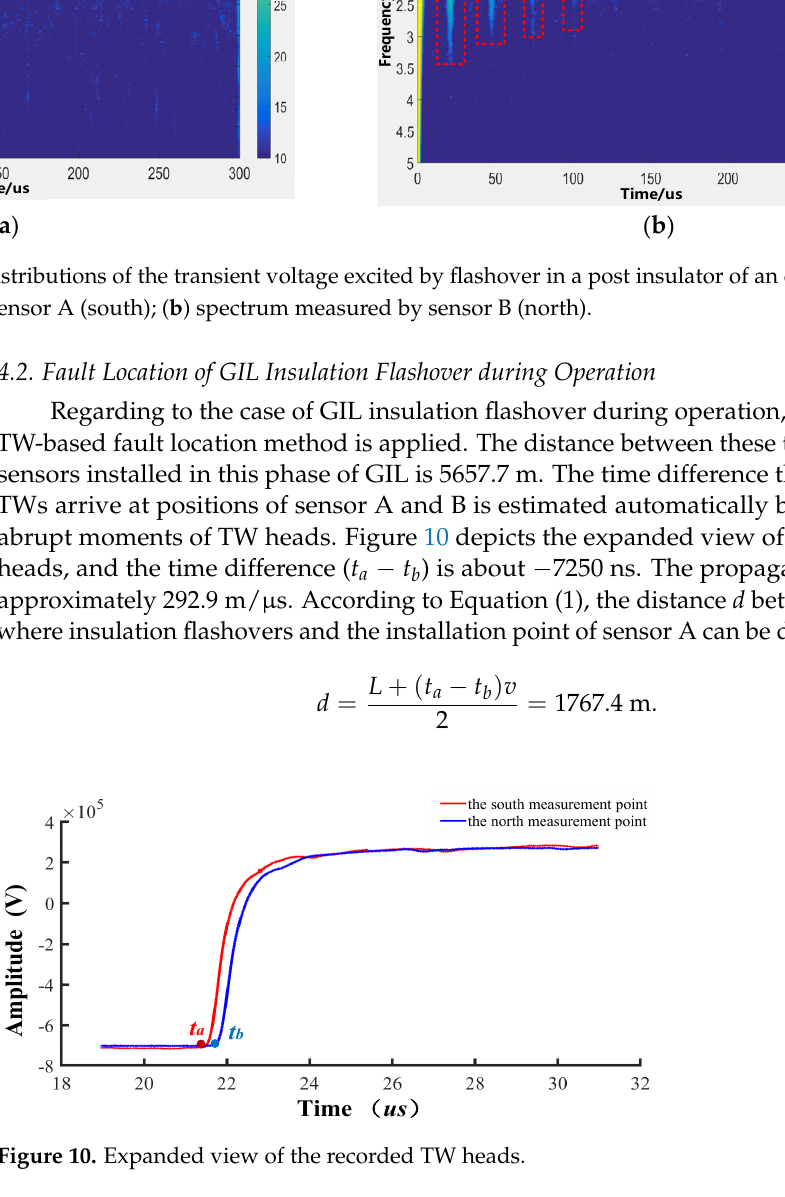
Figure 11. Inspection view of the fault location caused by flashover of a post insulator in GIL. 5. Conclusions In this application paper, a novel transient voltage on-line monitoring system, which is applied in an kV GIL project, is introduced. The effective measurement bandwidth ranges from 2.1 Hz to 230 MHz. The sampling rate is 250 MS/s, and the analog bandwidth is 100 MHz. In order to fast locate the malfunctioning GIL chamber and shorten the maintenance time, a two-terminal TW-based fault location method relying on this moni- toring system is developed and implemented. Based on two real-world cases of insulation breakdown captured by the online monitoring system, the characteristics of the transient voltage waveforms in both time domain and time–frequency domain are presented and discussed. The following conclusions are drawn: (1) The instantaneous frequency of the transient voltage caused by a SF 6 gap breakdown case during withstand test exceeds 35 MHz, whereas the instantaneous frequency excited by post insulator flashover during operation is around 3.5 MHz, which is much lower. Therefore, the characteristics of waveforms could indicate different types of insulation breakdown. (2) Time–frequency analysis, can be used to estimate whether the GIL has secondary discharge by the time–frequency distribution of transient voltage. (3) The accuracy of the applied fault location method is validated in the case of insulation flashover during operation. The location error of this case is 3.8 m and successfully recognizes the malfunctioning chamber. Author Contributions: Conceptualization, Z.Z. and W.L.; methodology, D.D.; software, Z.Z.; vali- dation, L.H.; formal analysis, Z.Z.; investigation, J.L.; resources, C.B.; writing—original draft prep-